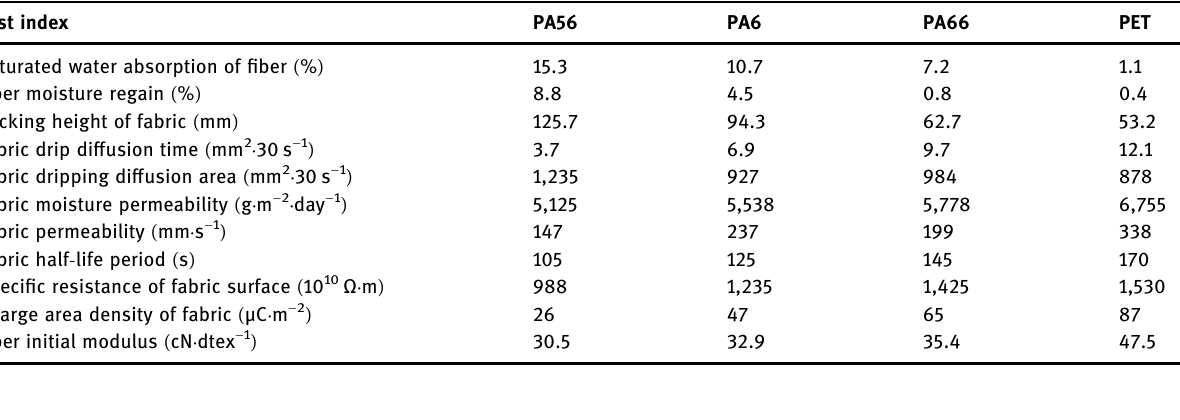
Table 1: Analysis of performance indexes of fi ber samples and fabrics ( 44 dtex/36 f FDY )